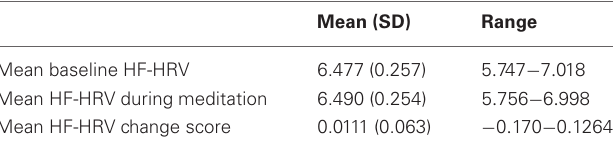
Table 2 | Mean HF-HRV values in normalized units